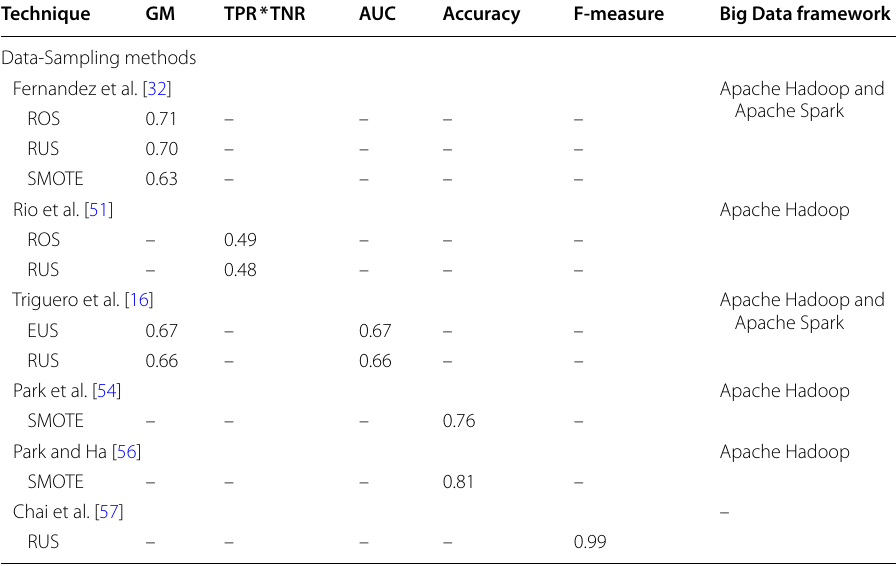
Table 3 Performances’ summary of Data-Level methods